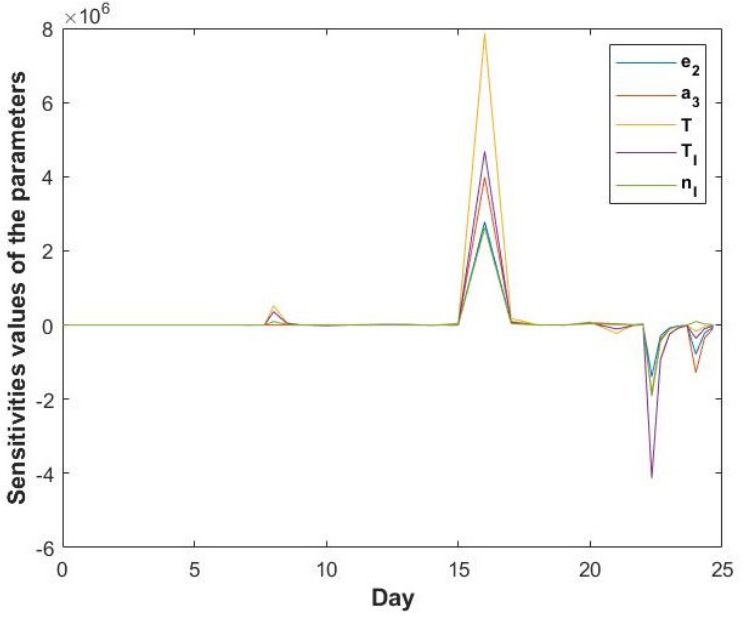
Figure 10. Sensitivities of the parameters in Equation